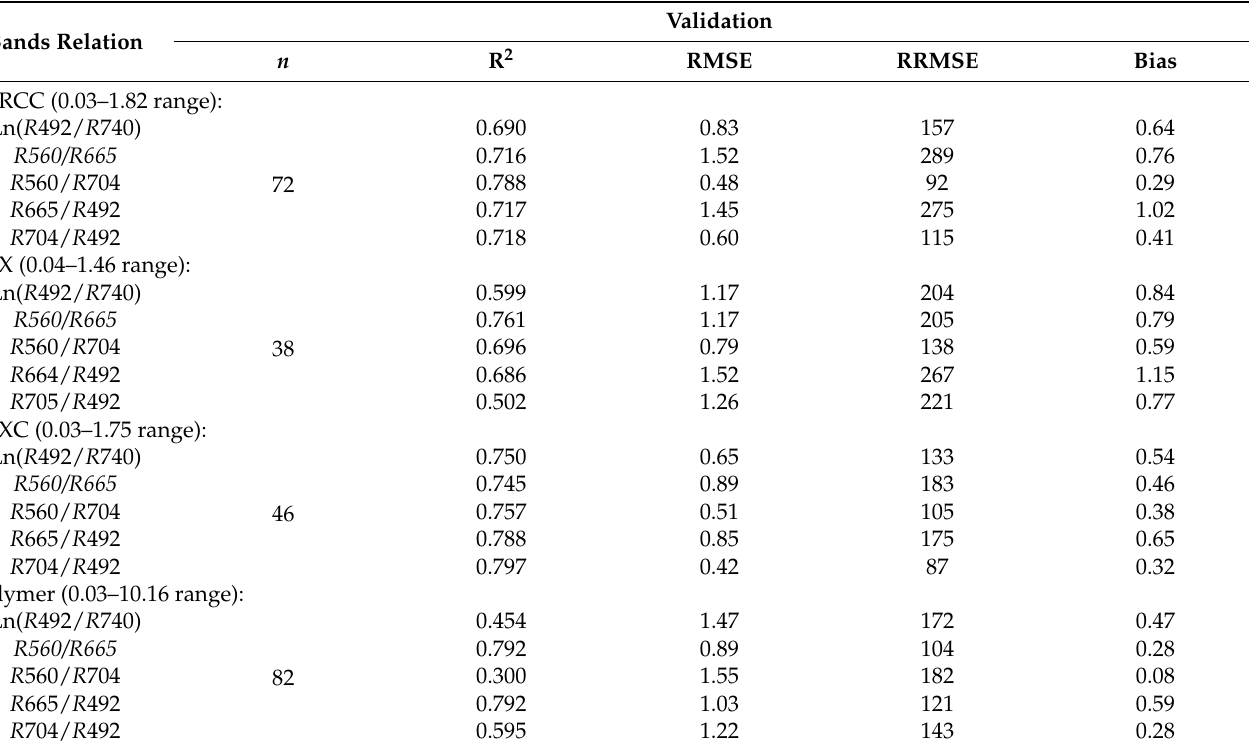
Table A3. CDOM validation results for in situ spectrometry waters quality algorithms and AC